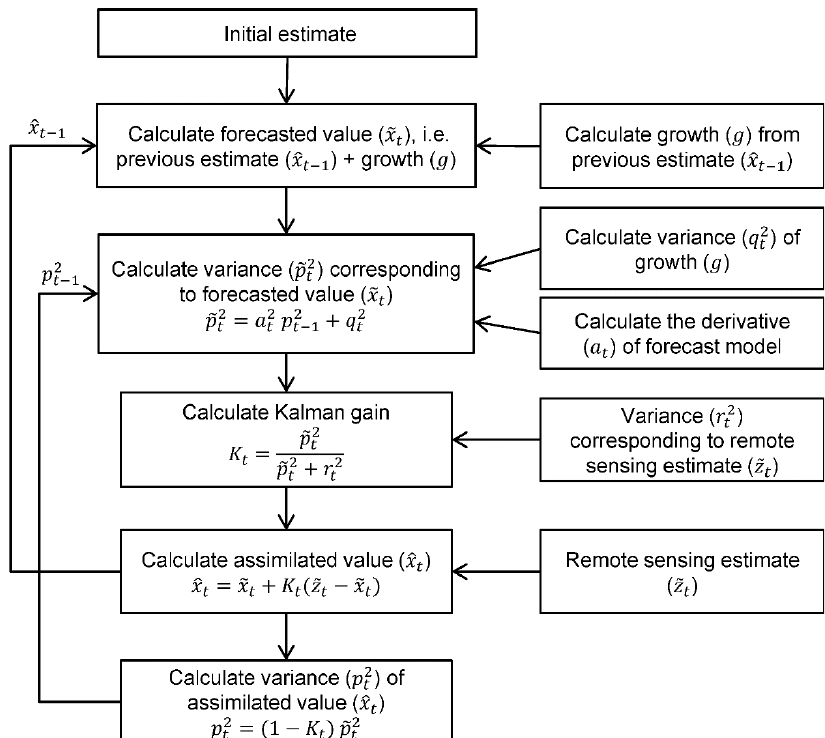
Figure 4. Flowchart of the implementation of the data assimilation framework.